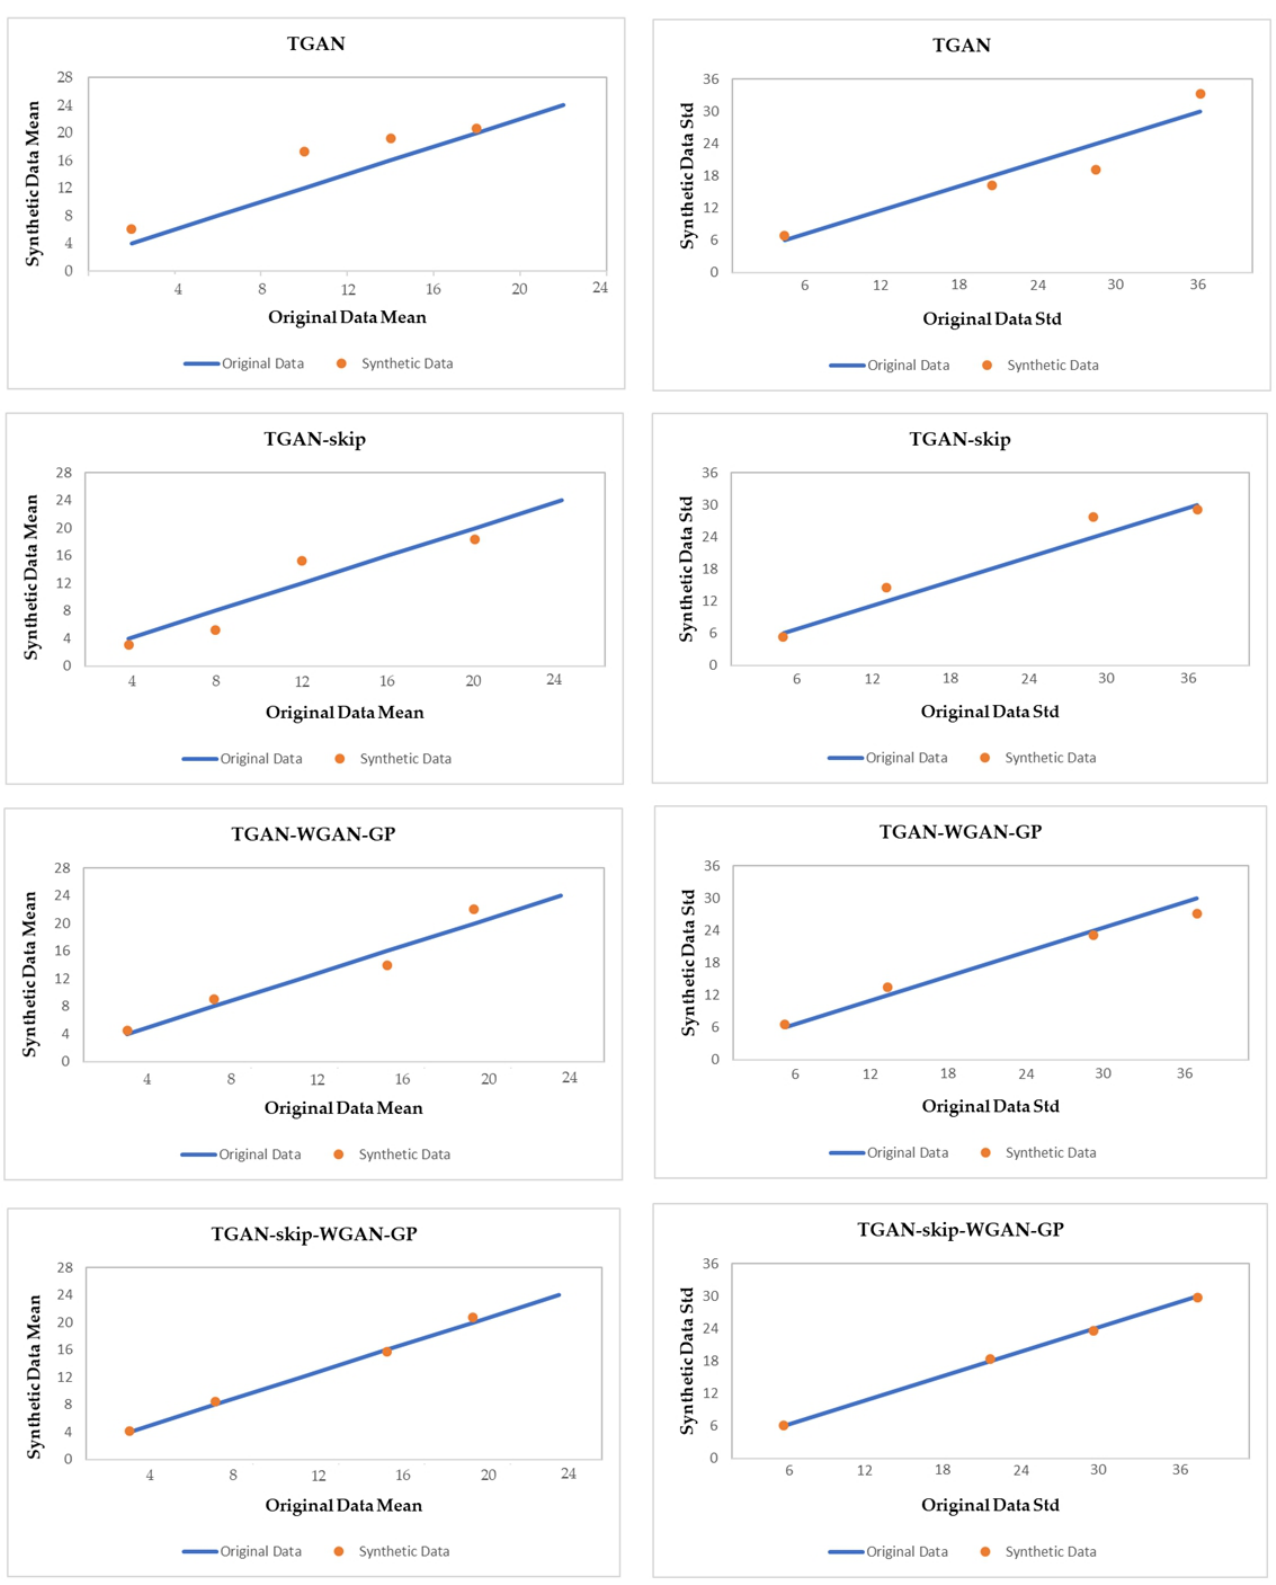
Figure 10. Mean and standard deviation comparison of different GAN models in our